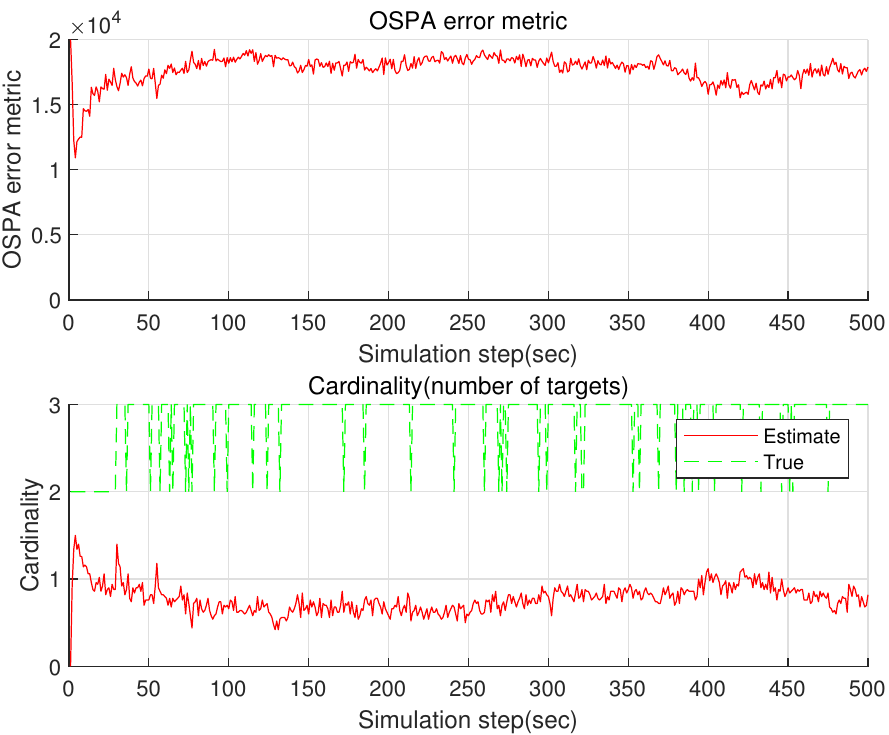
Figure 5. The OSPA and the cardinality of the proposed GM-PHD in the case where B = 1 is utilized. Setting B = 1 corresponds to the case where we apply a single EKF in the GM-PHD. Compared with the case where B = 50 is used (Figure 4), the estimation accuracy decreases